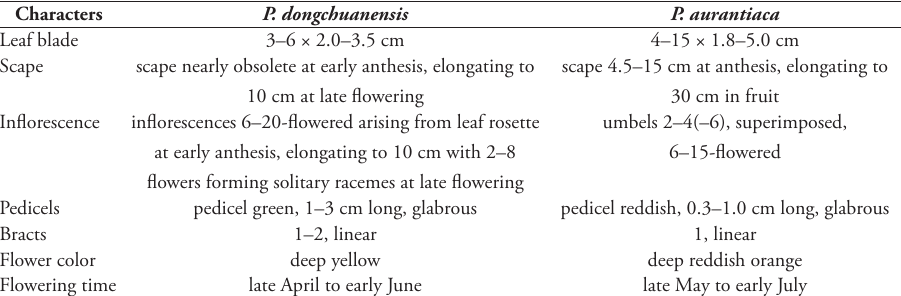
Table 1. Morphological and phenological comparisons between Primula dongchuanensis and P. aurantiaca .